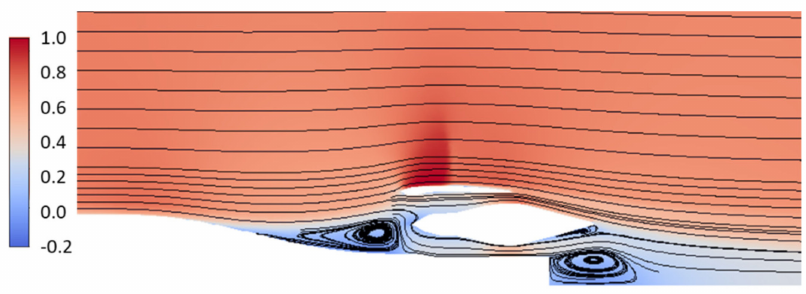
Figure 7. Contours of Mach number (normalized) for baseline case, 2D